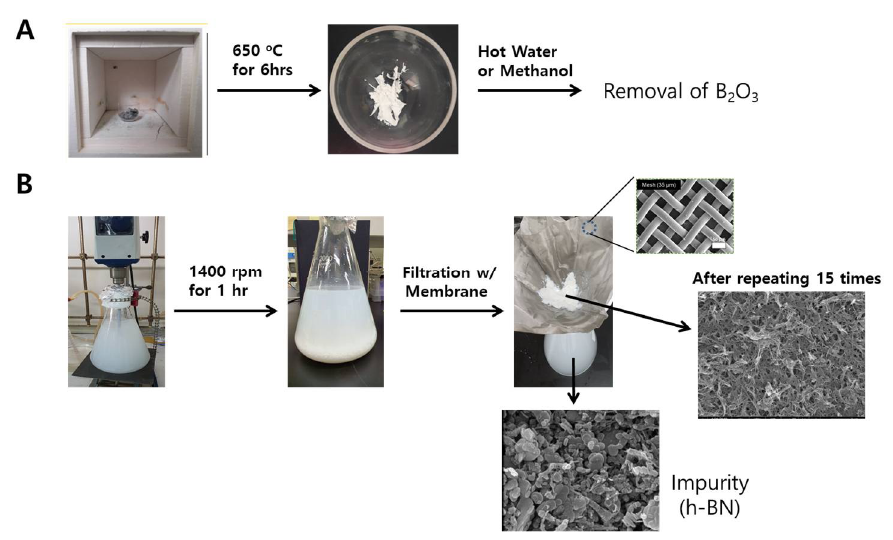
Figure 1. Boron nitride nanotubes (BNNT) purification processes used in the present case: ( A ) process